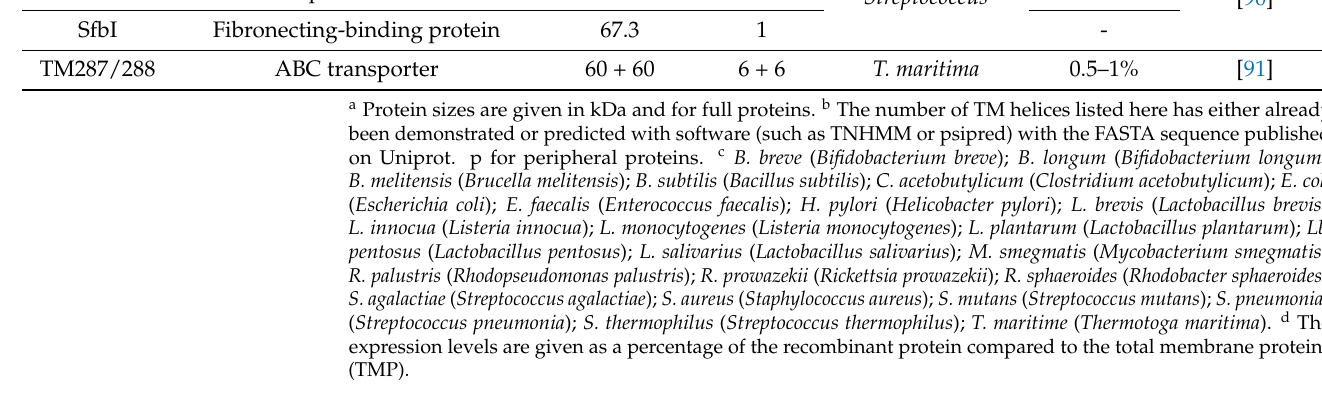
Table 4. List of eukaryotic